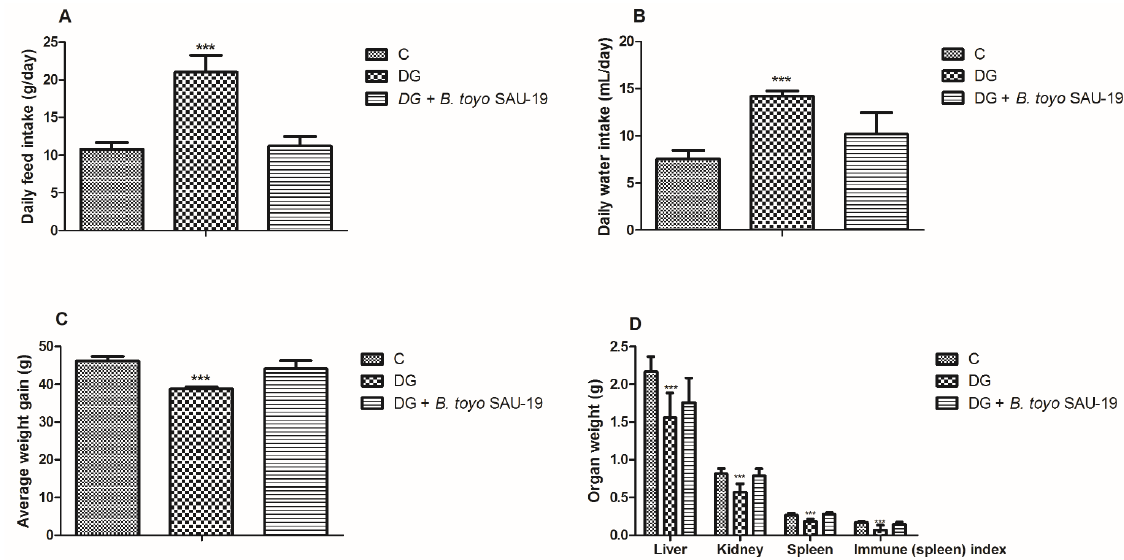
Figure 1. Effects of Bacillus toyonensis SAU-19 on the growth performance in HFD/STZ-induced T2DM mice. ( A ) Daily feed intake (g/day). ( B ) Daily water intake (mL/day). ( C ) Average weight gain (g). ( D ) Organ weight (g) and immune (spleen) index. Values are shown as mean ± Sd. Bars with *** are statistically different ( p < 0.05), DG compared with the control (C) and B. toyo SAU-19 groups ( n = 8).